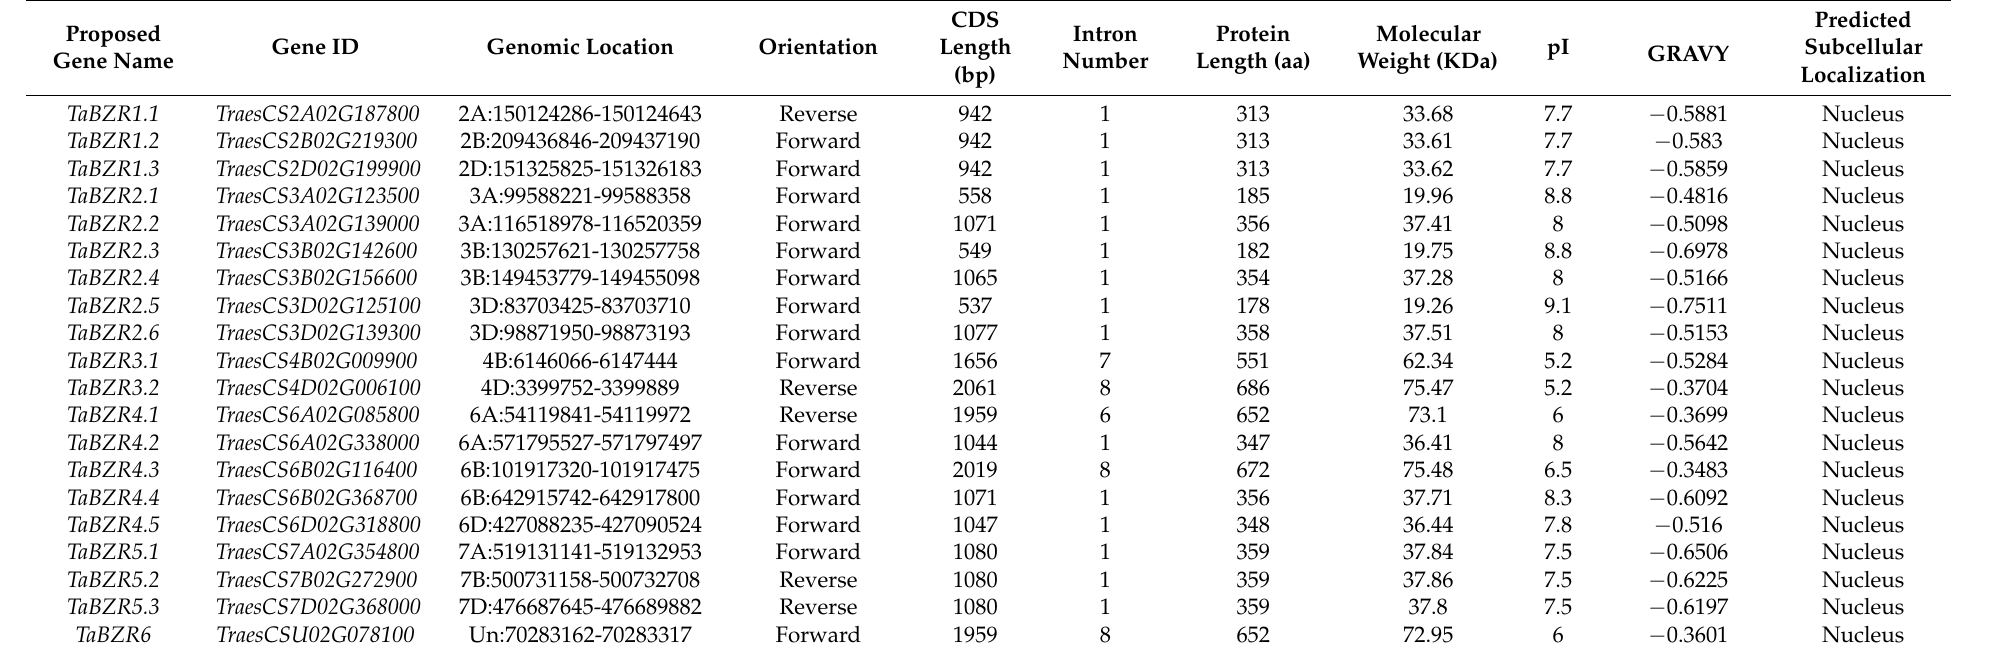
Table 1. Nomenclature and characteristics of the putative brassinazole-resistant (BZR) proteins in